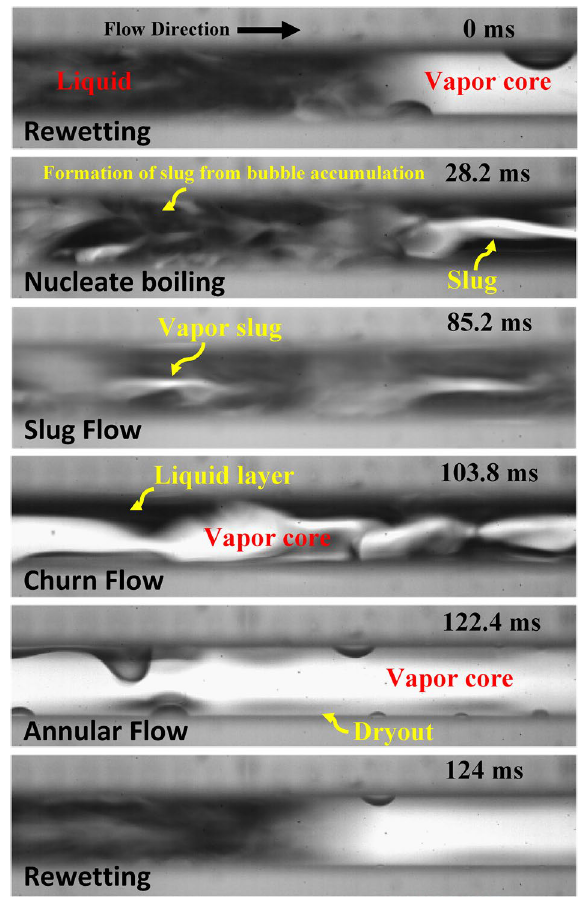
Figure 5. Flow pattern transitions in flow boiling plainwall microchannels at mass flux, 400 kg/m 2 s and heat flux, 30 W/cm 2